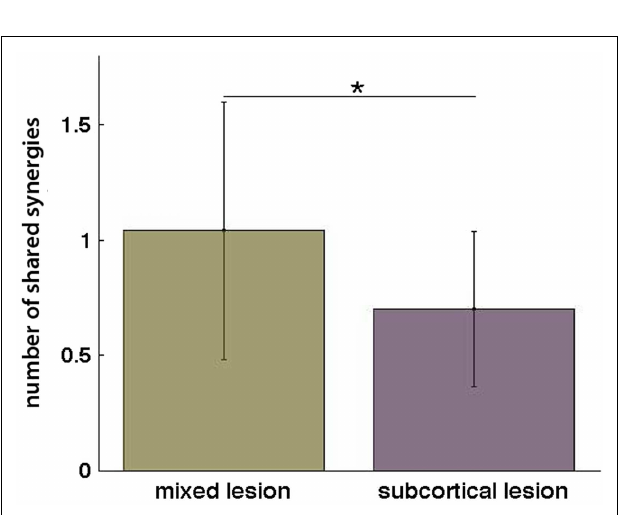
FIGURE 6 | Number of shared synergies in the mixed lesion and subcortical lesion group (mean ± SD) . * p = 0.05.